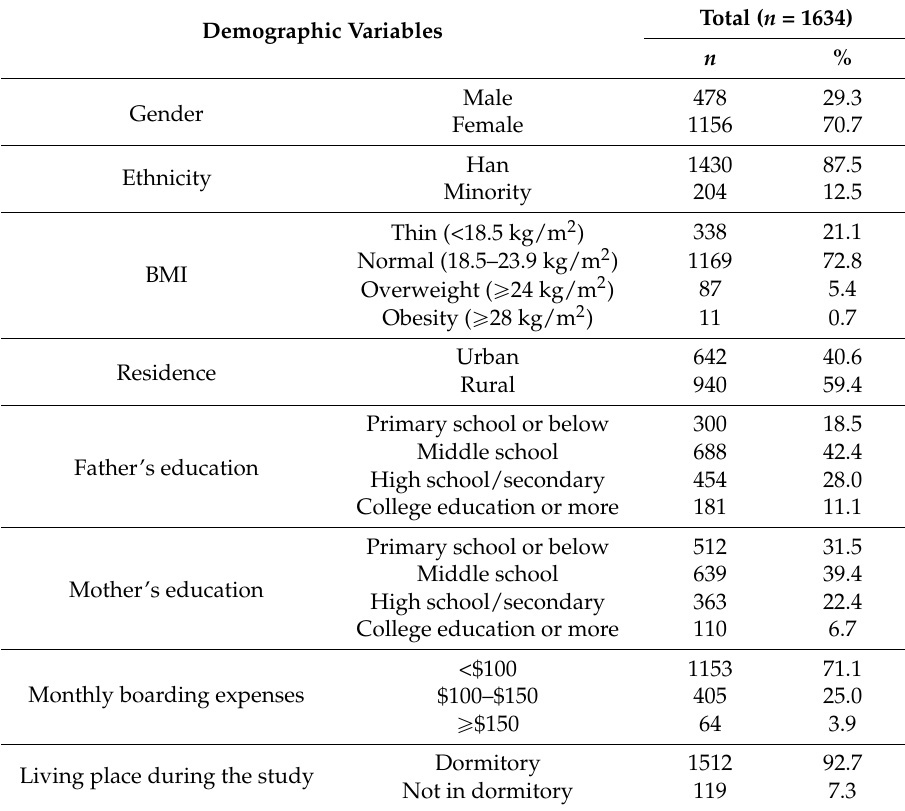
Table 1. Demographic characteristics of the study population ( n =